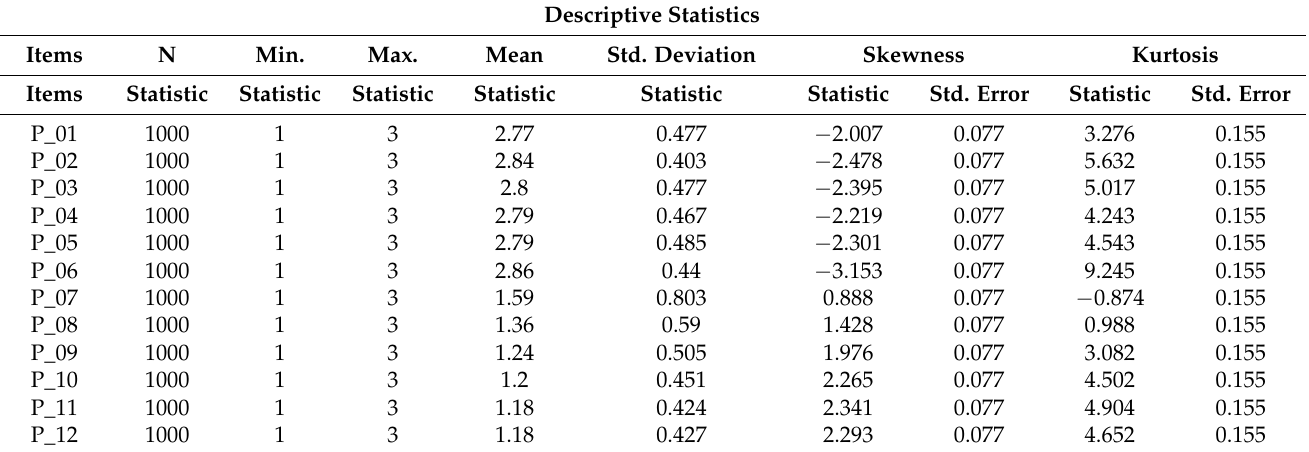
Table 7. Descriptive statistics for each